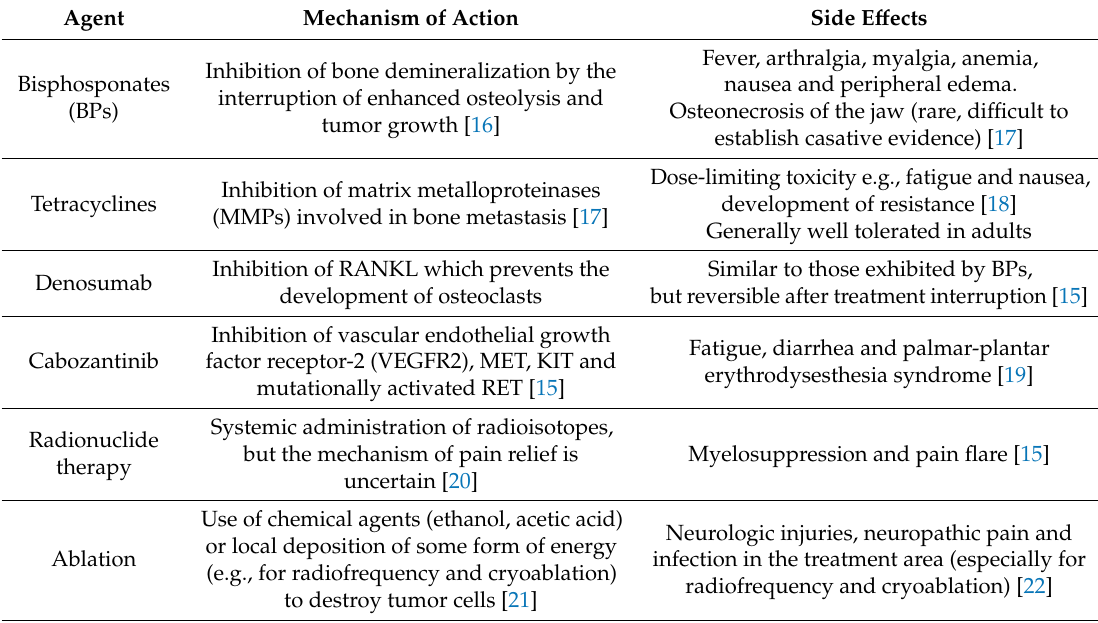
Table 2. Common drugs and therapeutic techniques for the treatment of bone